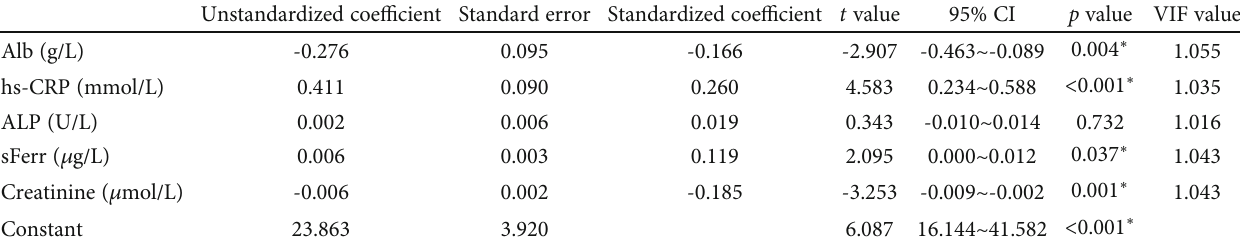
Table 3: Multiple linear regression analysis for ERI.